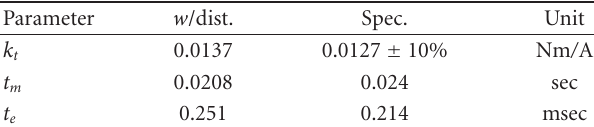
Table 3: FC130 test results.